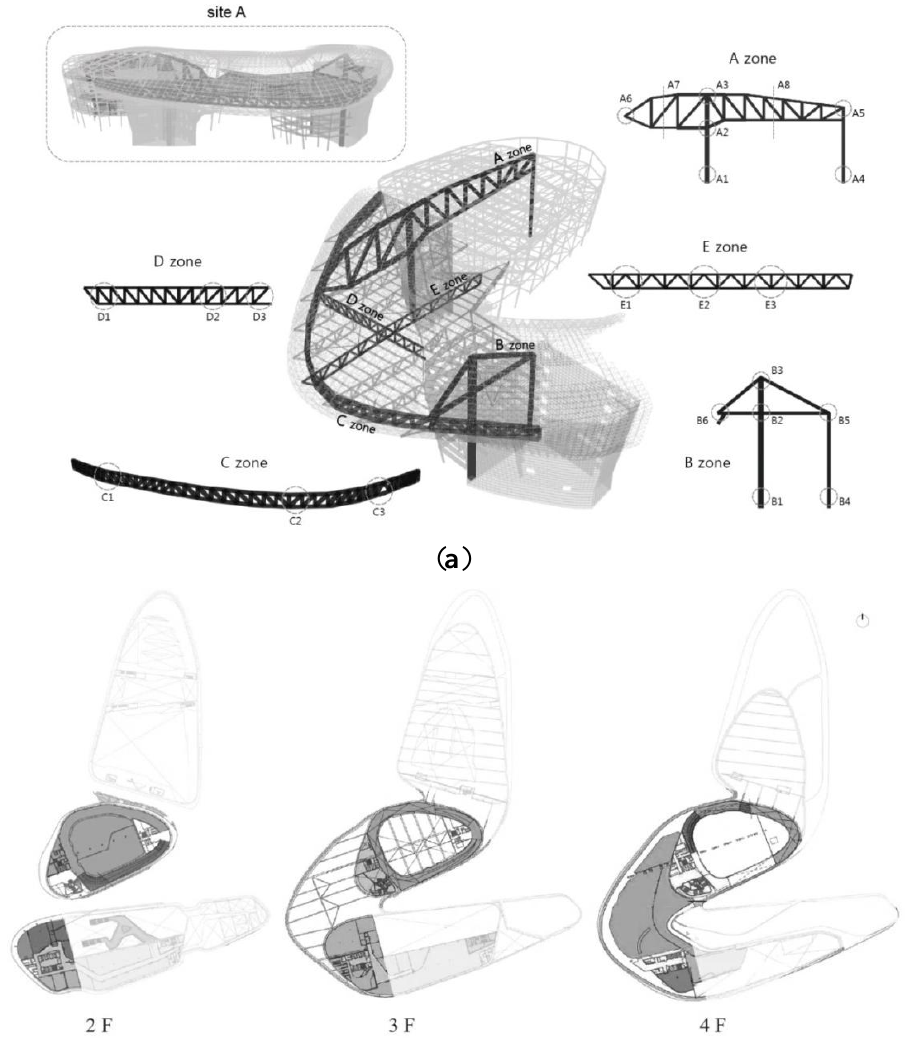
Figure 7. The irregular shaped buildings of D-Building. ( a ) Zoning of monitoring units; ( b ) The architectural floor